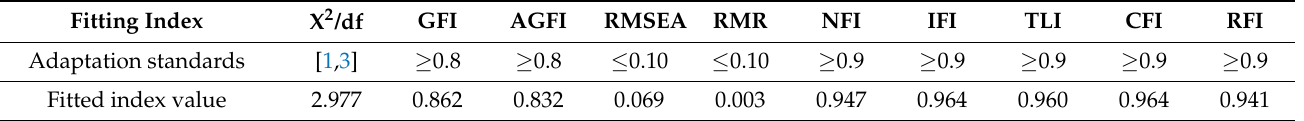
Table 7. Table of overall fitting